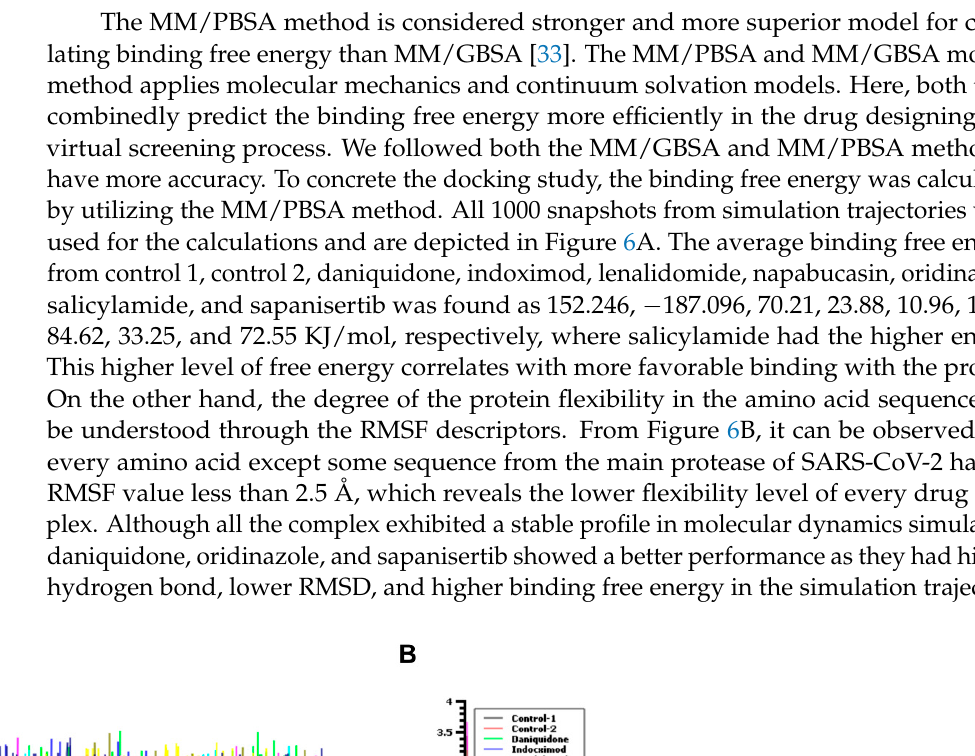
Figure 5. The molecular dynamics simulation study of the docked complex, ( A ) root mean square deviation (RMSD), and ( B ) hydrogen bond were assessed from the simulation trajectories.